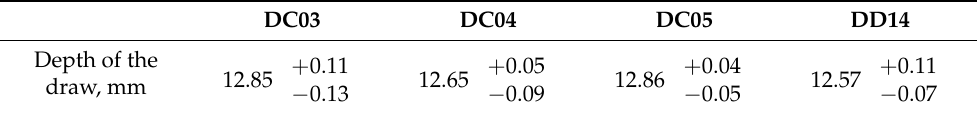
Table 5. The results for the measurements of the depth of the draw. DC03 DC04 DC05 DD14 Depth of the + 0.11 draw, mm 12.85 −